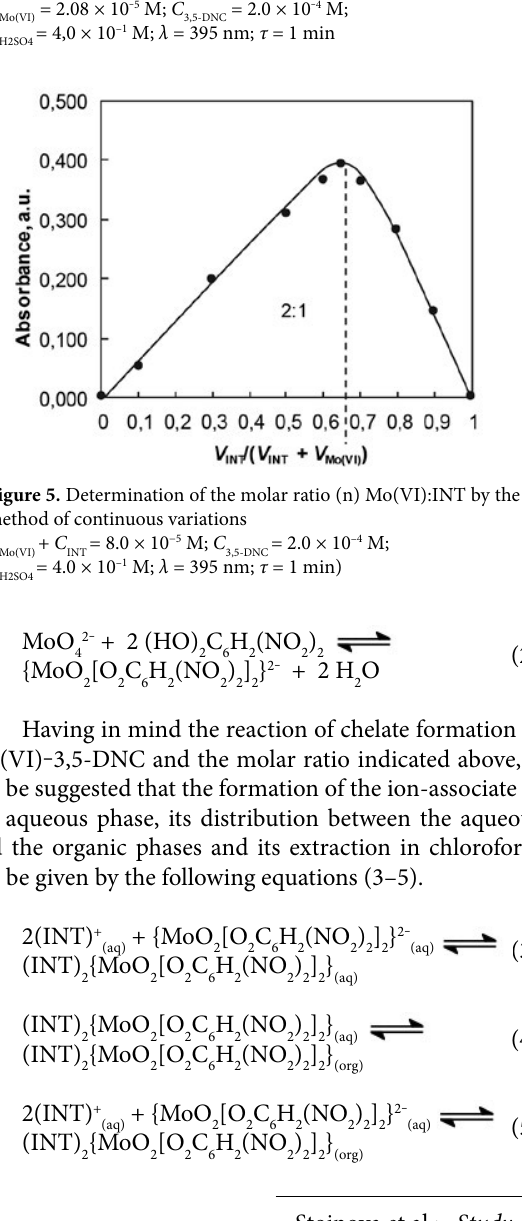
= 2.0 × 10 ‒4 M; 3,5-DNC